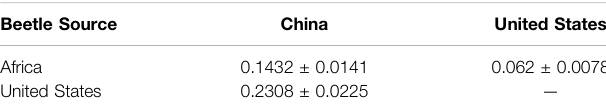
TABLE 1 | Pairwise fi xation index F ST of the three beetle sources along the genome (mean ± SE). The beetles collected from China and the United States showed the highest divergence.